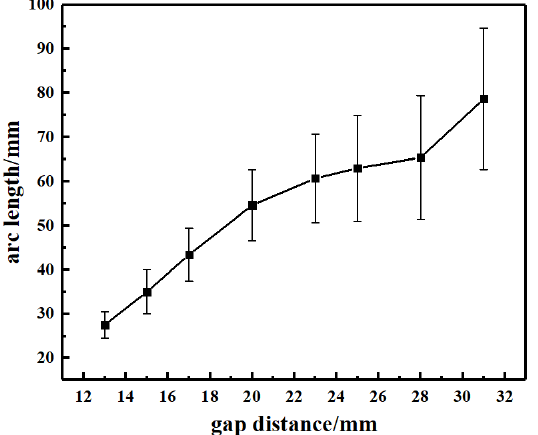
Figure 7. The length of arc discharge as a function of the gap distance.